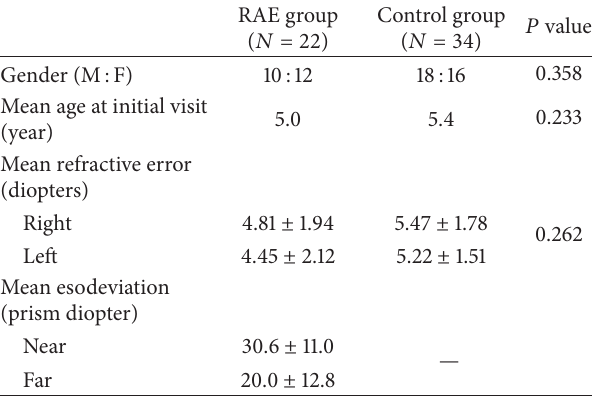
Table 1: Demographics of RAE patients and controls.